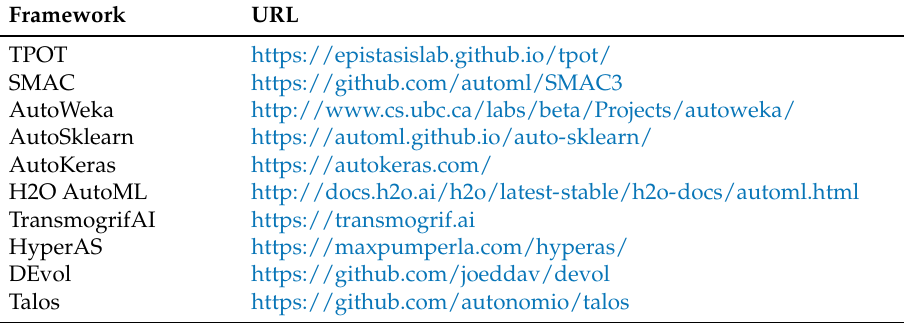
Table 1. Overview of hyperparameter optimization and tuning